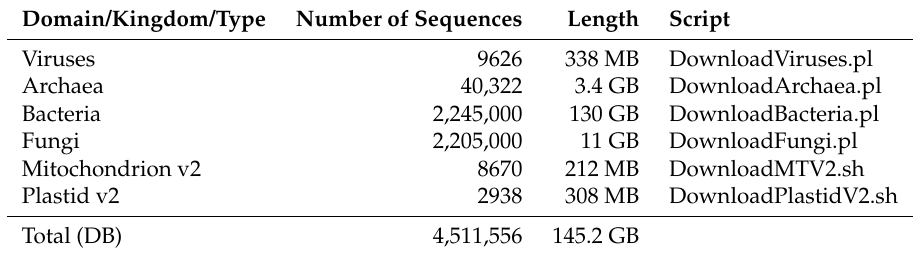
Table 1. Characteristics of the database before filtering and the corresponding downloaded